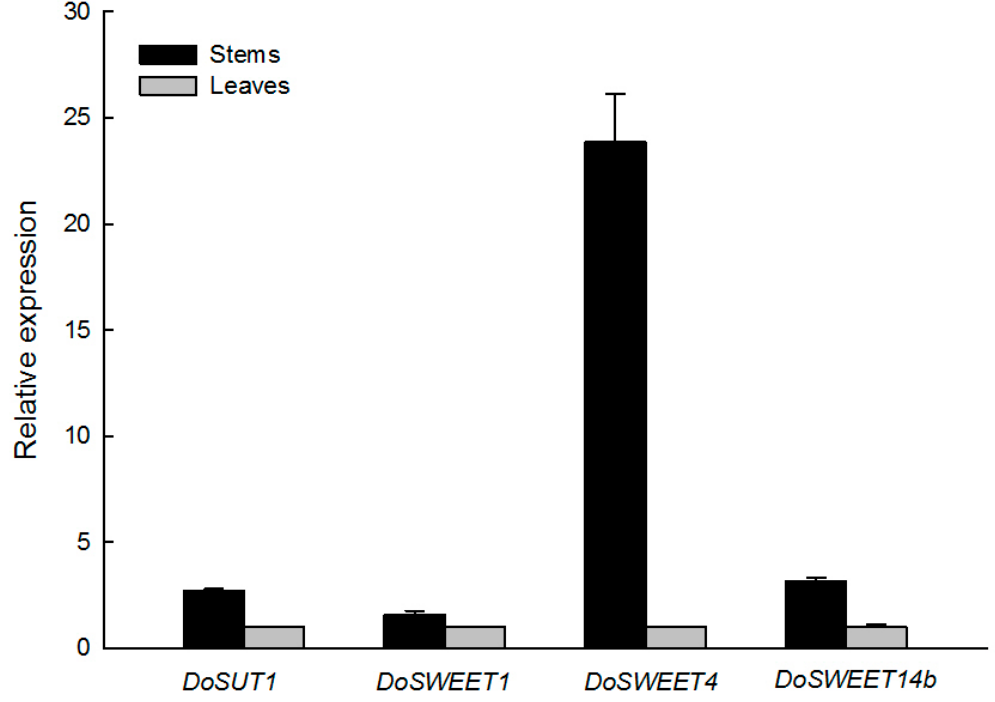
Figure 4. RT-qPCR analysis of DoSWEETs in leaves and stems. Data are shown as means ± standard error ( n = 3).